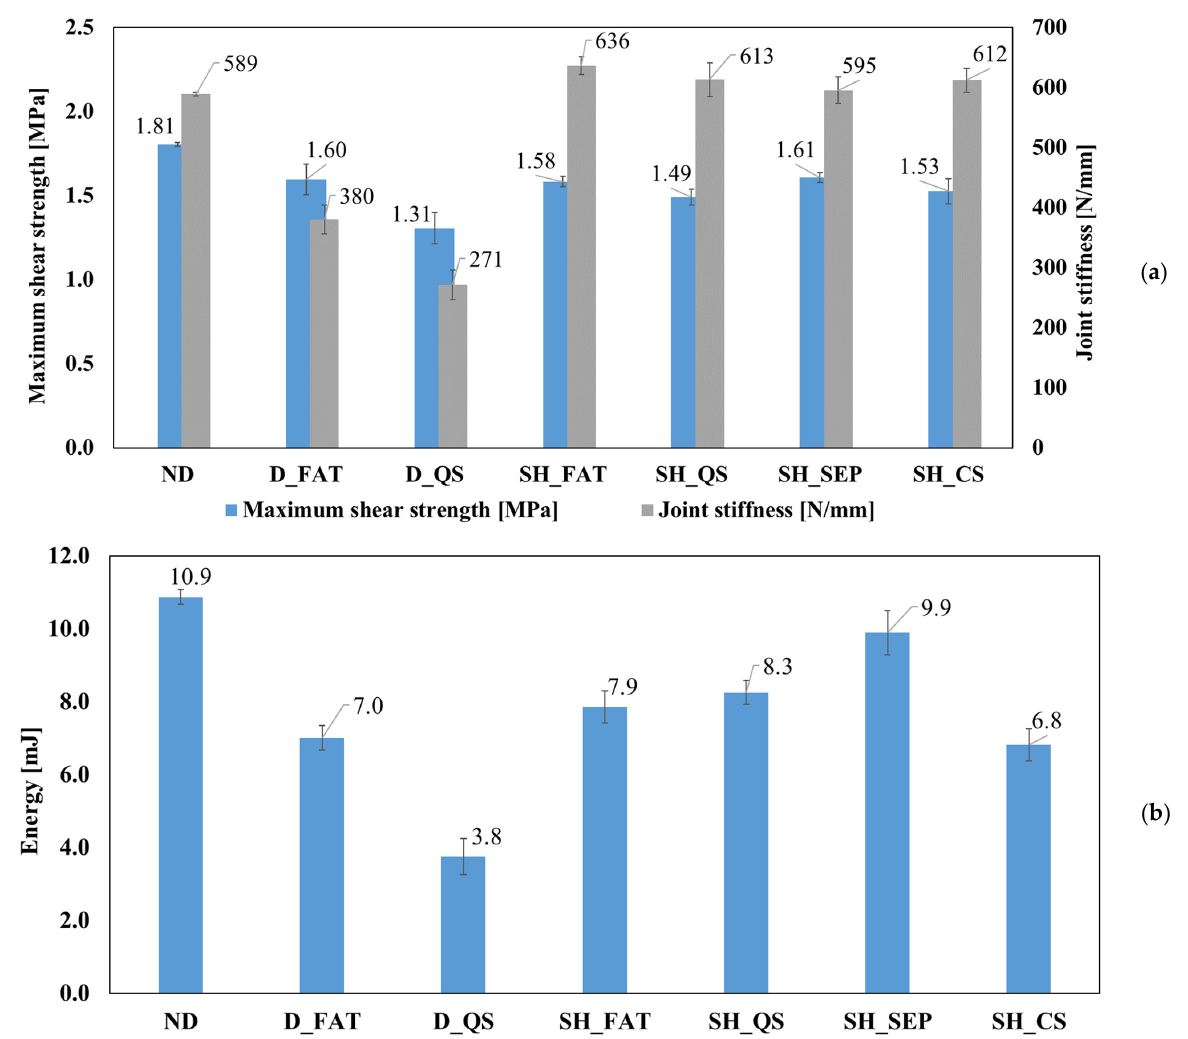
Figure 3. ( a ) Maximum shear strengths and joint stiffnesses of the undamaged, damaged, healed, and rebonded SLJ tests; ( b ) maximum absorbed energy of the undamaged, damaged, healed, and rebonded SLJ tests.